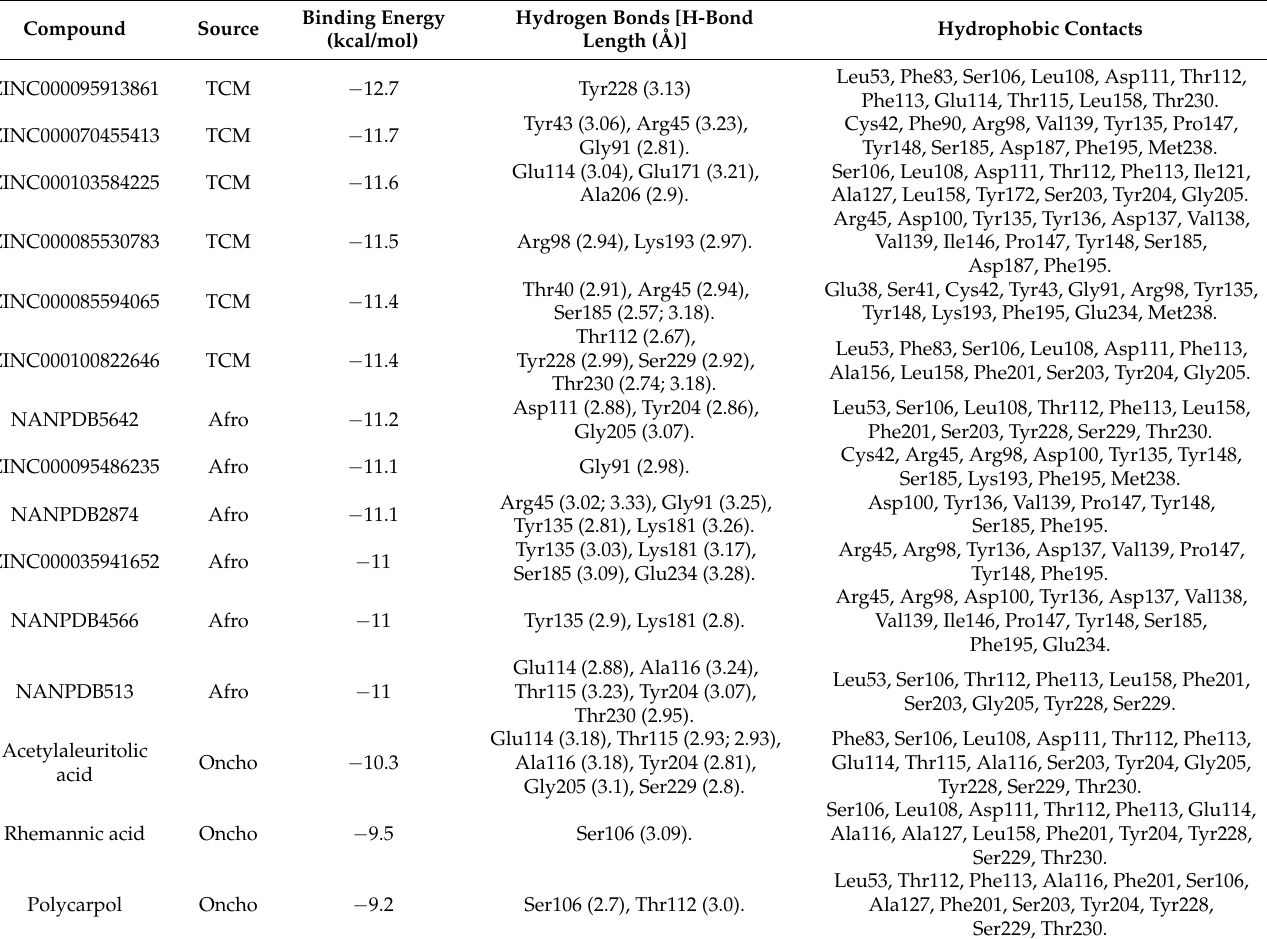
Table 3. Binding energies and interactions of some selected compounds which docked deep into the